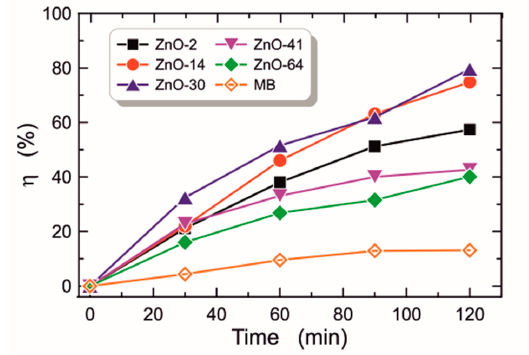
Figure 12. Plots of photodegradation efficiency ( ƞ ) as function time for the degradation of MB dye without (orange empty diamonds) and with the presence of the catalyst.